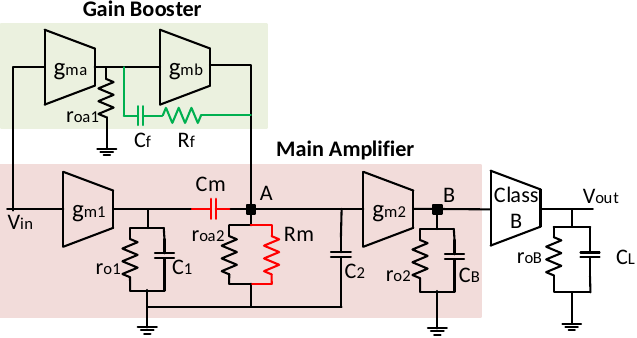
Figure 2. Architecture of the proposed gain-boosted two-stage operational amplifier with load-insensitive stability